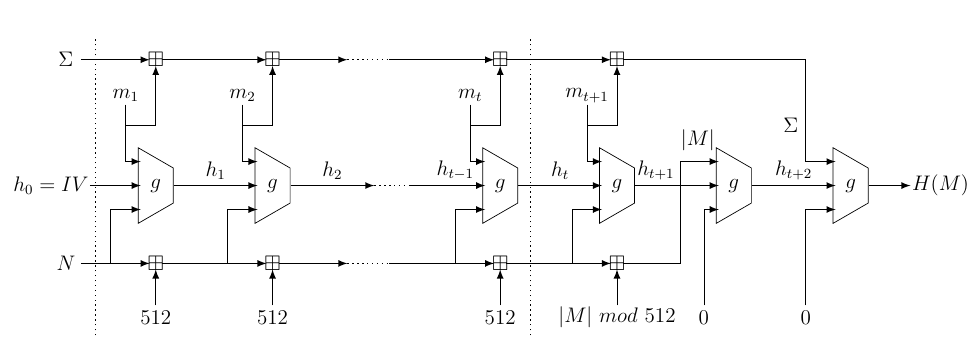
Figure 4: The Streebog hash